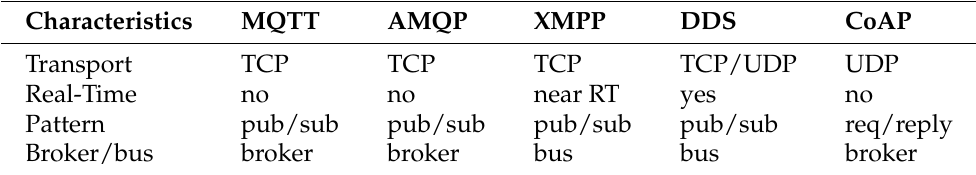
Table 3. Most relevant characteristics of network transport protocols [36] as UDP (User Data- gram Protocol) and TCP (Transmission Control Protocol), including the latency level (real-time), the adoption of publish/submit or request/reply patterns, and acknowledgment (broker or bus- based). MQTT—Message Queuing Telemetry Transport; AMQP—Advanced Message Queuing Protocol; XMPP—Extensible Messaging and Presence Protocol; DDS—Data Distribution Service; CoAP—Constrained Application